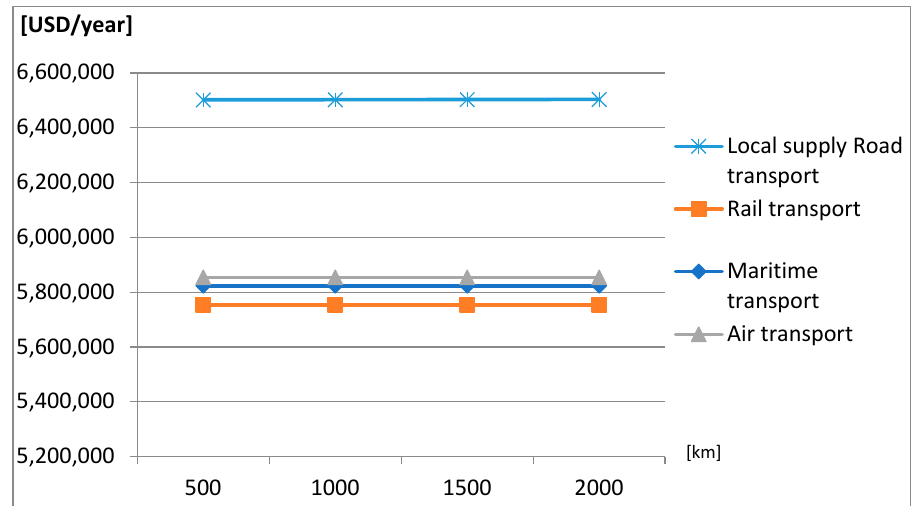
Figure 2. Results of simulations—impact on total costs (electronic lower value).